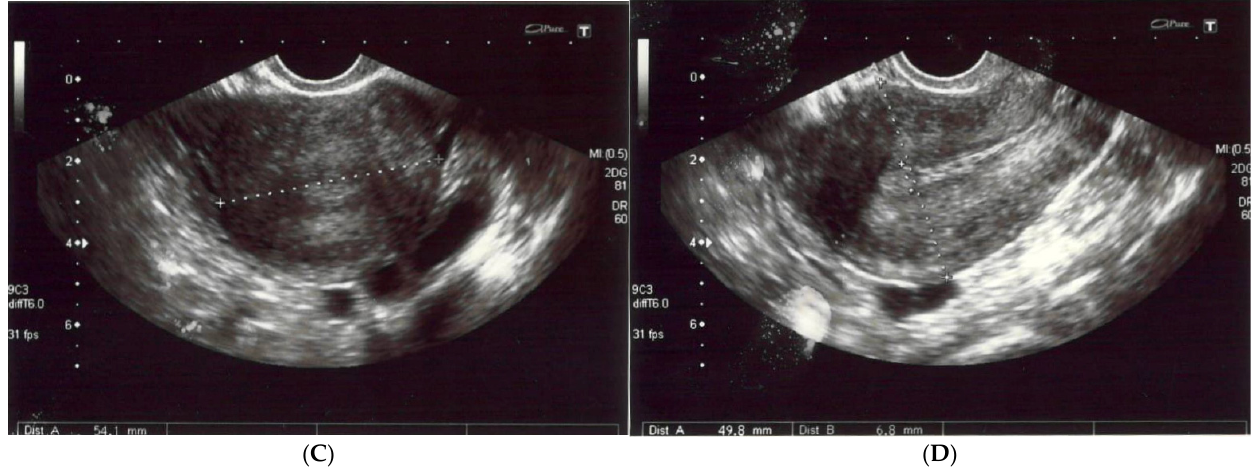
Figure 1. ( A , B ) The left and right ovaries, with their diameters. The right ovary measured 25 × 15 mm and the left ovary 24 × 14 mm. ( C ) The transverse plan of the uterus at its widest dimensions. In this plane, the uterine width (Ut-W) was measured. The uterus was of normal size in anterior flexion. ( D ) The midsagittal plane of the uterus showing the uterine fundus, myometrium, endometrium (6 mm thick), isthmus, cervix and cul-de-sac. The patient reported nonspecific signs of fatigue and impaired concentration. The magnetic resonance imaging (MRI) of the head revealed a 16 × 18 × 12 mm tumor in the region of the clivus. On T1-weighted imaging, the lesion was isointense and peripherally enhanced after contrast administration. The borders of the lesion were hyperintense while the main part was isointense (Figure 2A). On T2-weighted imaging, the lesion was isointense as well (Figure 2B). On computed tomography (CT), the tumor had smooth outlines with a hypersclerotic rim. It was located centrally and did not show any penetration into the sinuses (Figure 2C). In diffusion-weighted imaging (DWI), no signals of recent ischemic changes were found. The radiology images were also nonspecific and suggested chordoma or fibrous dysplasia.